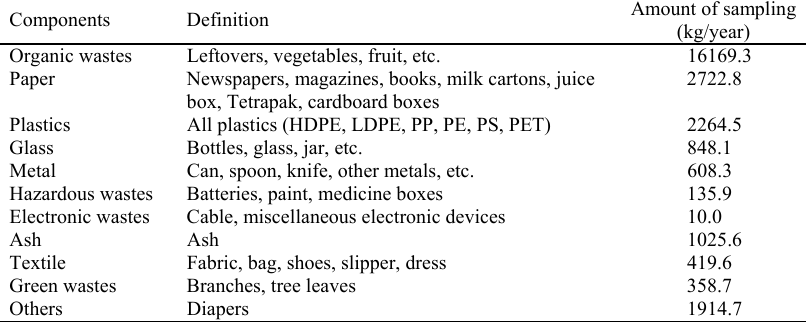
Table 1: Solid waste components are examined in the study area